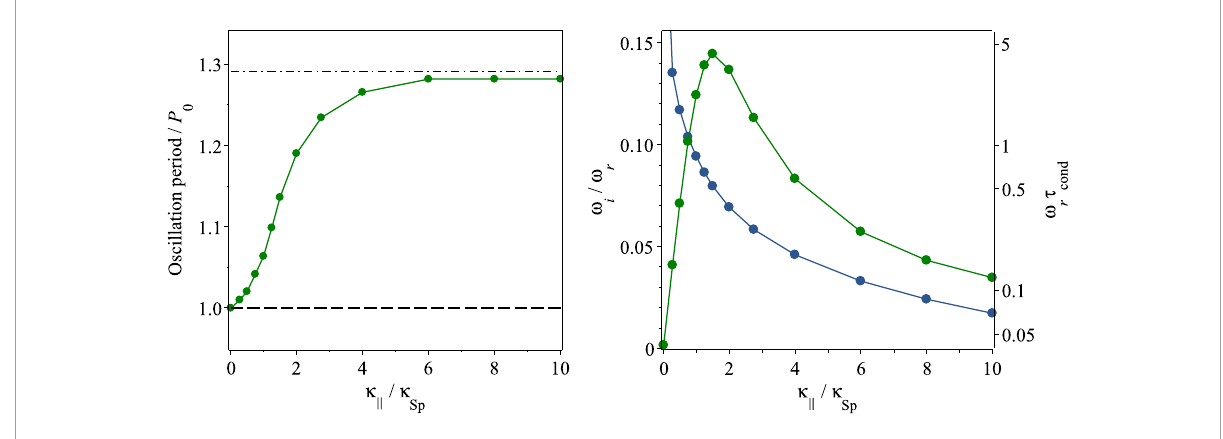
FIGURE 2 Left: Slow-wave oscillation period, P , estimated empirically via the fast Fourier transform of the numerical solution for the plasma velocity perturbation, vs. the coefficient of the field-aligned thermal conduction normalised to the standard Spitzer value. The horizontal dashed and dot-dashed lines show the period values in the ideal adiabatic and isothermal limits, obtained with the standard adiabatic and isothermal sound speeds, C s and C s /√ γ , respectively. Right: Dependence of the ratio of the imaginary part ω i = 1 / τ D to the real part ω r = 2 π / P of the slow-wave angular frequency ω on the field-aligned thermal conduction coefficient (green), with τ D being the oscillation exponential damping time estimated empirically from the numerical solution. The dark blue line in the right panel shows the dimensionless parameter ω r τ cond , with τ cond = ρ 0 C V λ 2 / κ ‖ being the characteristic time scale of thermal conduction.